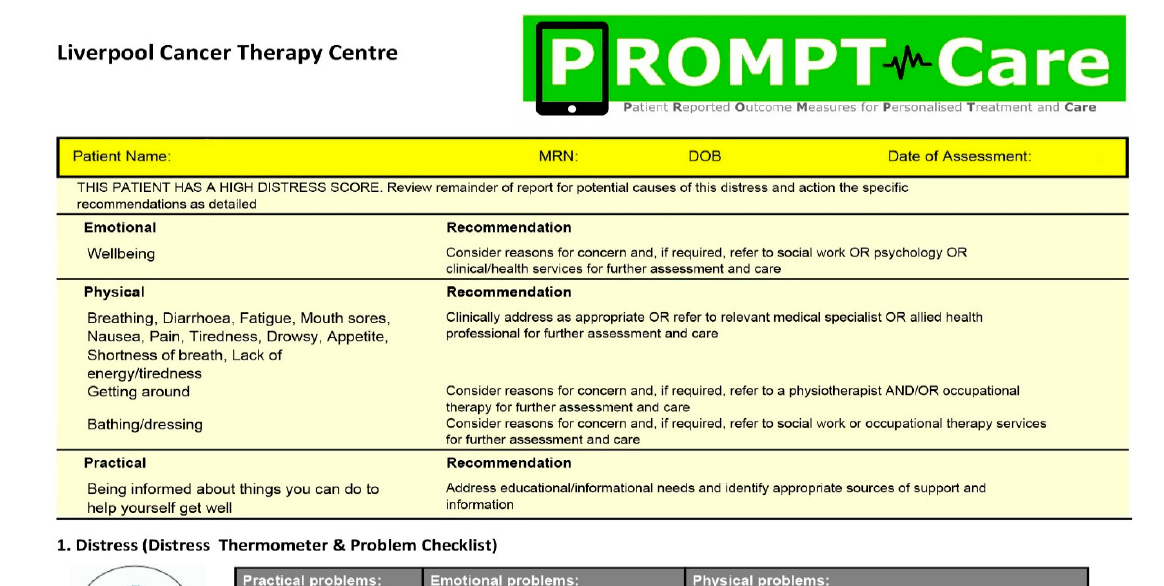
Figure 1. Clinical alert E-mail.